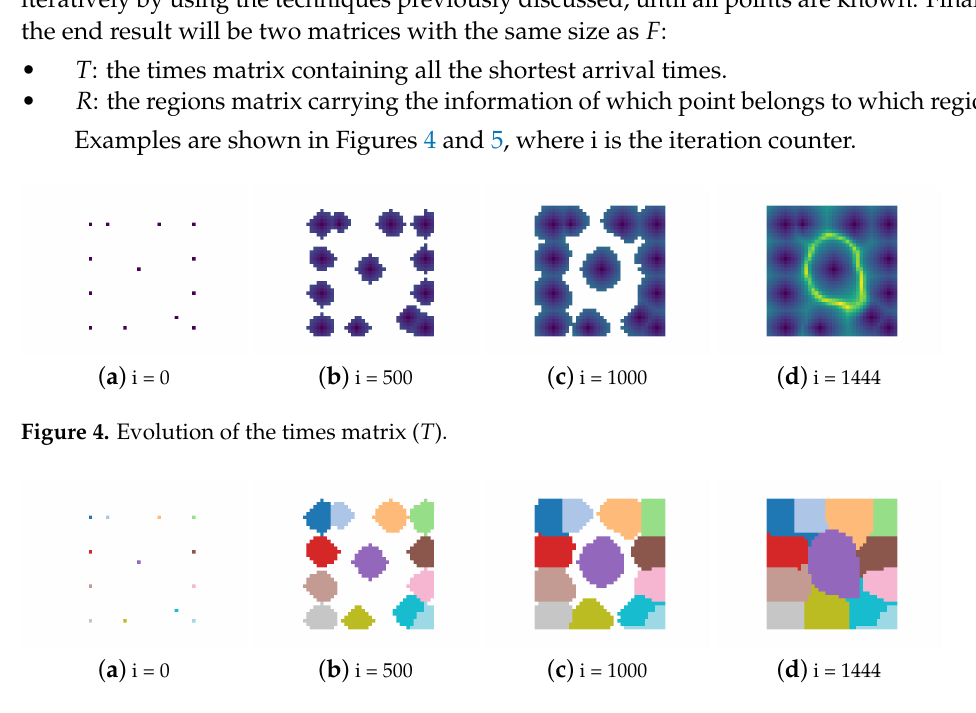
Figure 5. Evolution of the regions matrix ( R